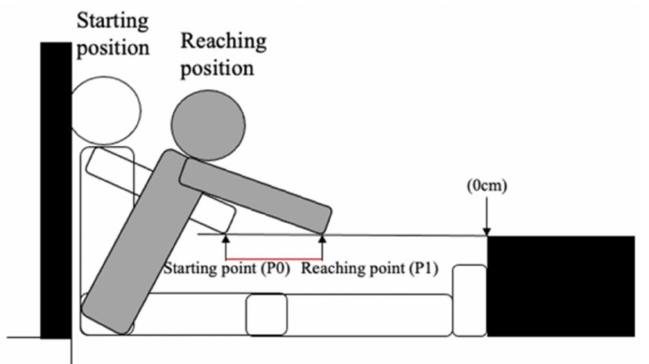
Figure 2. Illustration for MSR distance. An example of a 4-year-old boy: starting point is − 16 cm and reaching point is − 5 cm. Then his MSR distance score is 11